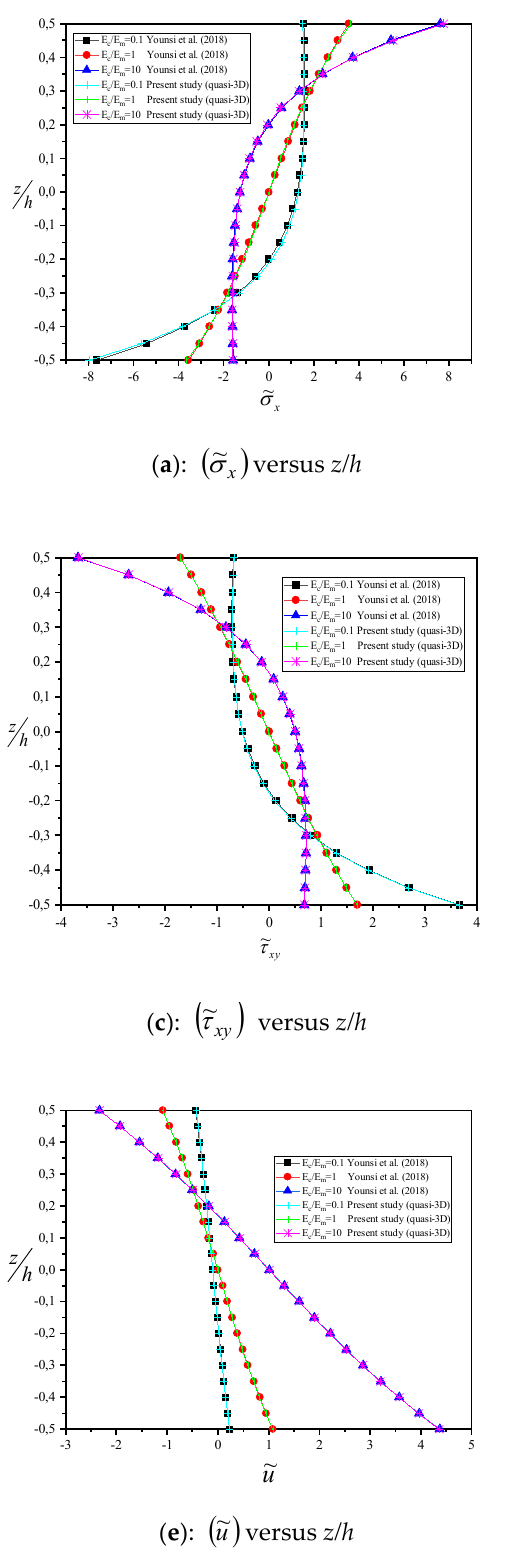
(cid:0) (cid:1) (cid:101) σ x , (cid:101) σ z , (cid:101) τ xy , (cid:101) τ xz